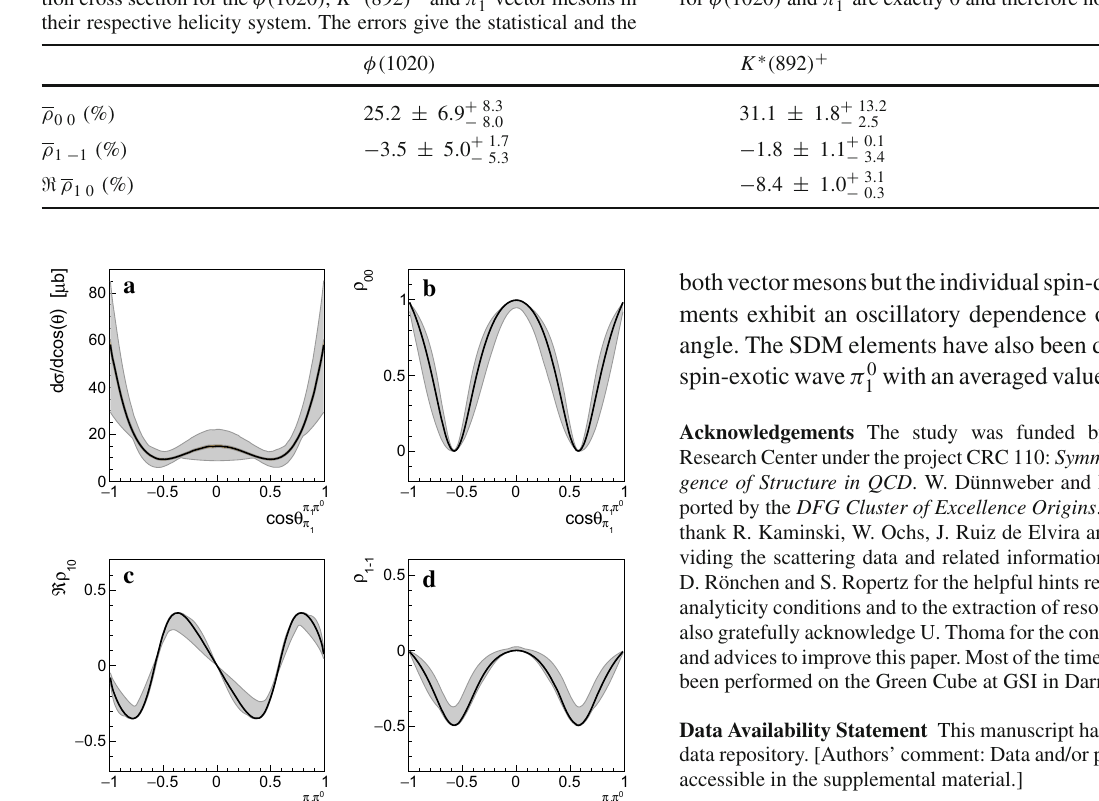
vector mesons in 1